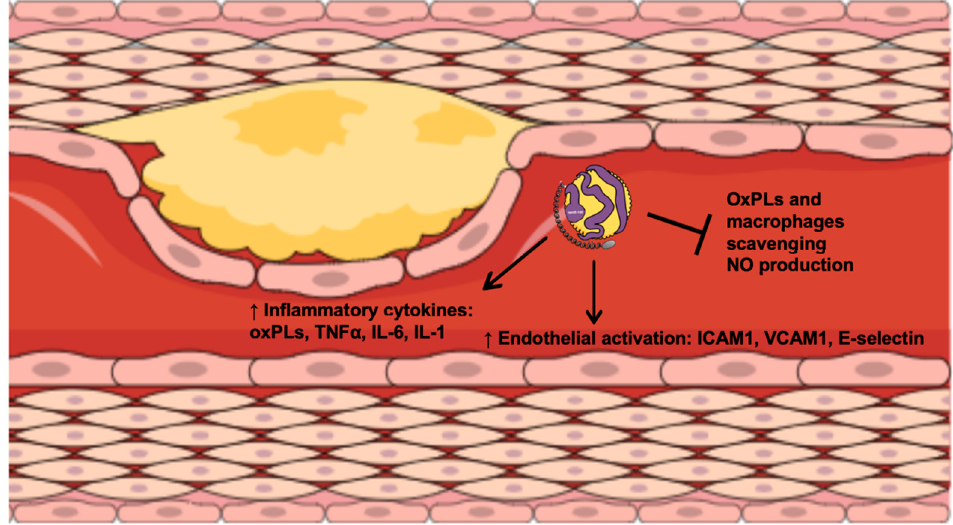
Figure 2. The role of Lp(a) in inflammation. OxPLs, oxidized phospholipids; TNF α , tumor necrosis factor- α ; IL, interleukin; ICAM1, intercellular adhesion molecule-1; VCAM1, vascular cell adhesion protein-1; NO, nitric oxide.